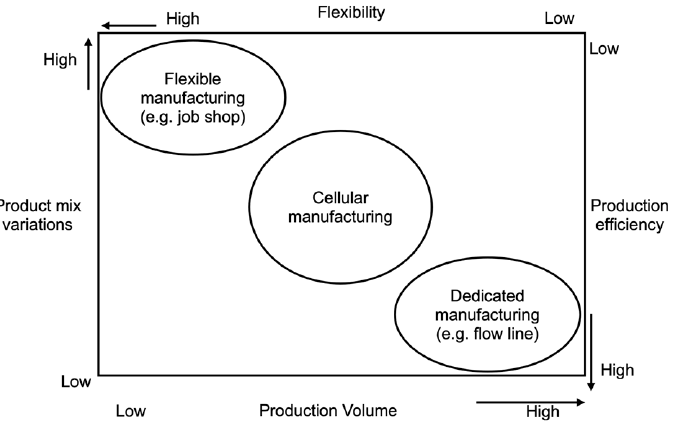
Figure 1. Comparison of cellular manufacturing systems with dedicated and flexible systems.